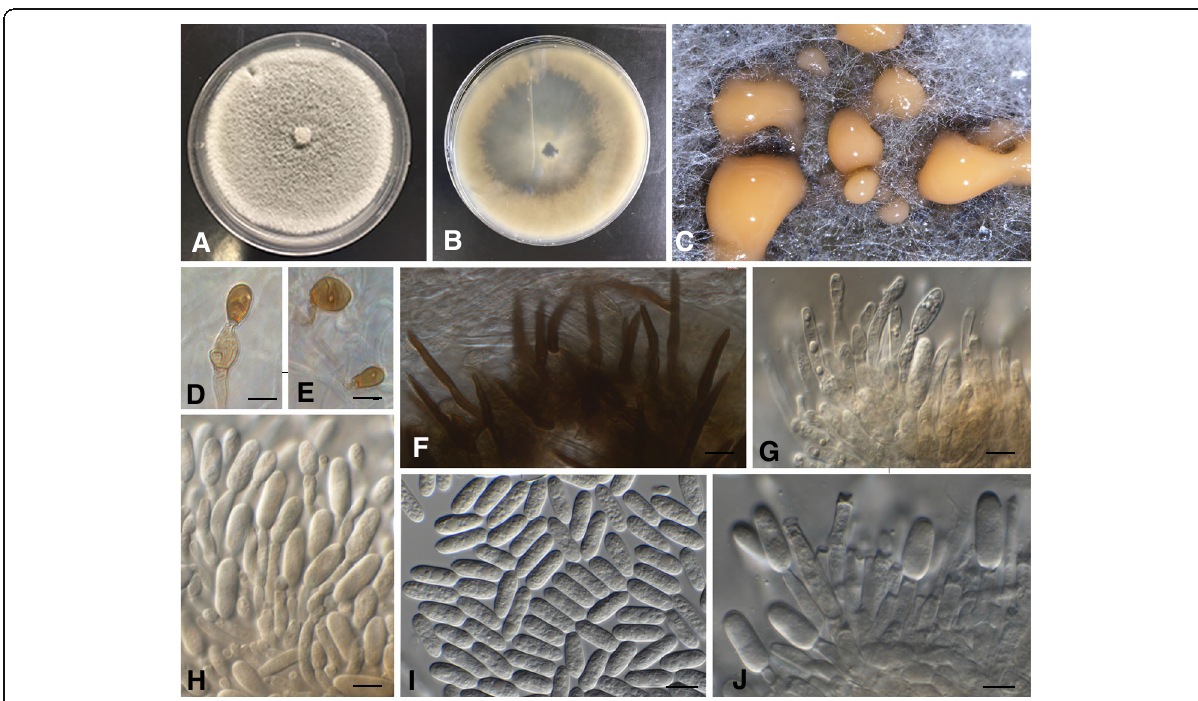
Fig. 7 Colletotrichum makassarense (CBS 143664) . a Colony on PDA. b Reverse side of the colony on PDA. c Conidiomata. d – e Appressoria. f Setae, g, h, j Conidiophores and conidia. i Conidia. Bars = 10 μ